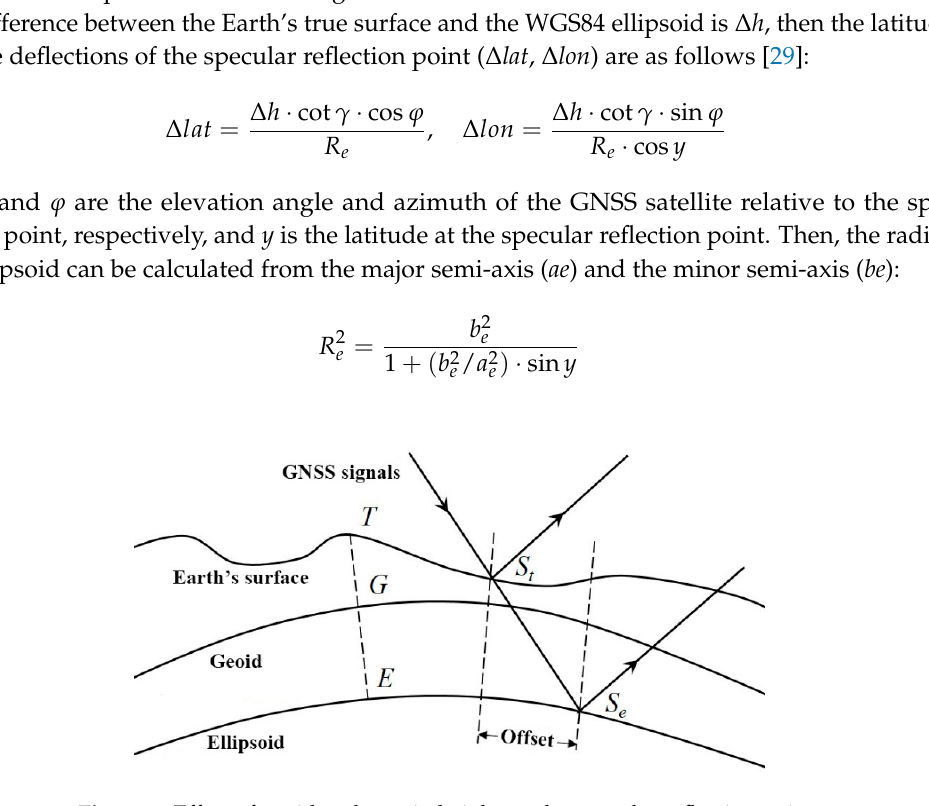
Figure 2. Effect of geoid and terrain height on the specular reflection point.